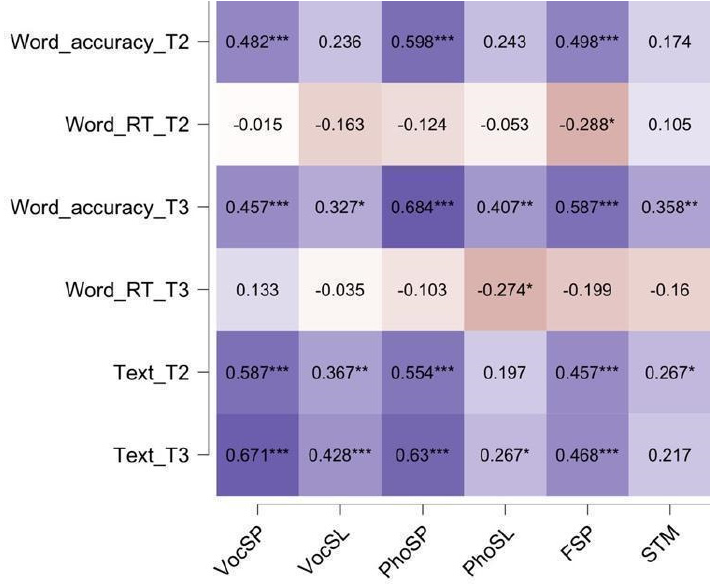
Figure 3. Correlation between predictors (X axis) and dependent variables (Y axis) with age partialled out. *** p < .001, ** p < .01, * p < .05.